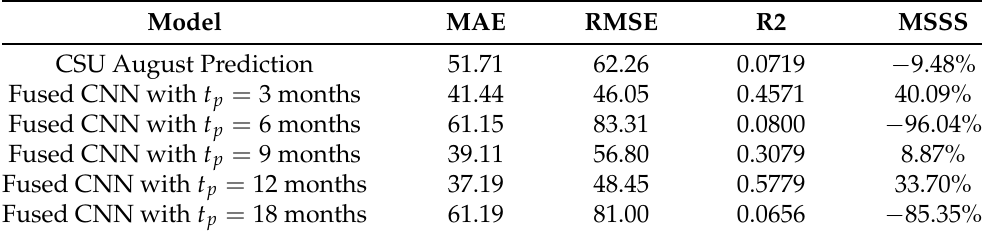
Figure 6. Annual Atlantic ACE predictions (2012 to 2018) using SVD based dimensionality reductions compared with the Poisson regression based seasonal predictions done by Colorado State University in August each year (dashed blue curve) and the original ACE curve (black curve). Table 2. ACE pediction efficiency metrics for different prediction windows compared with CSU seasonal predictions made in